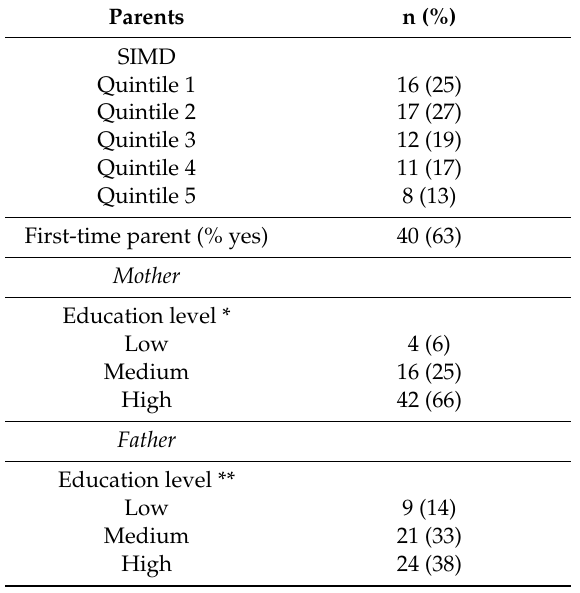
Table 1. Participant characteristics. Percentage (%) characteristics of the parents (n =